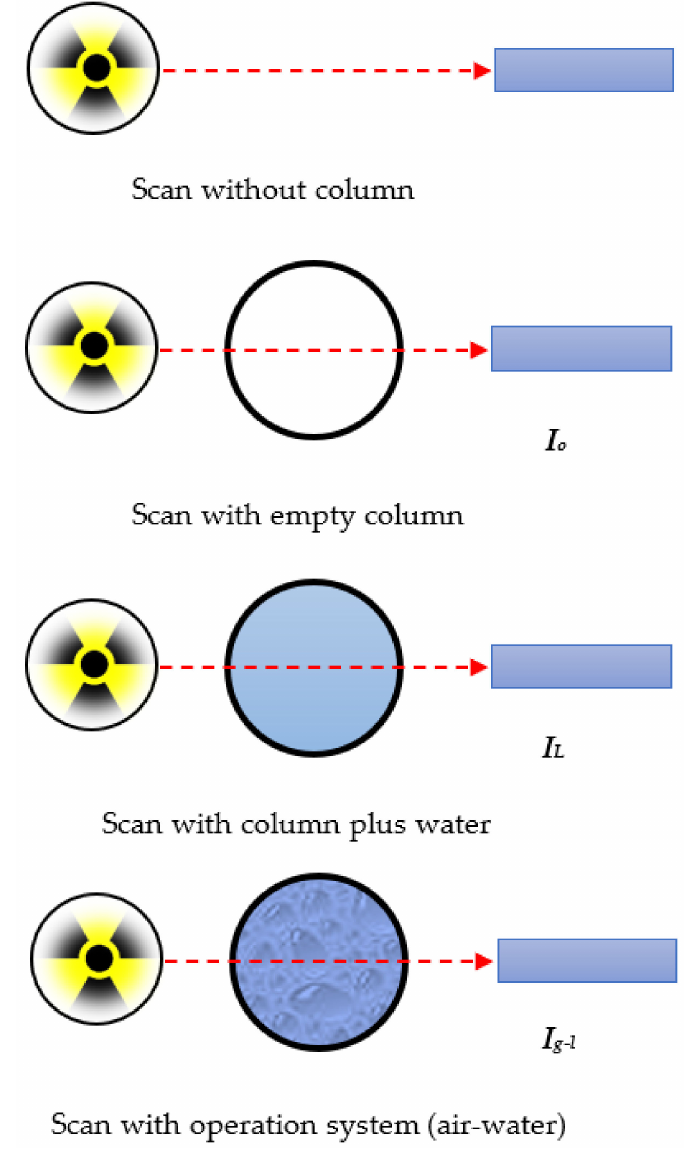
Figure 5. The procedure of experimental GRD scanning split